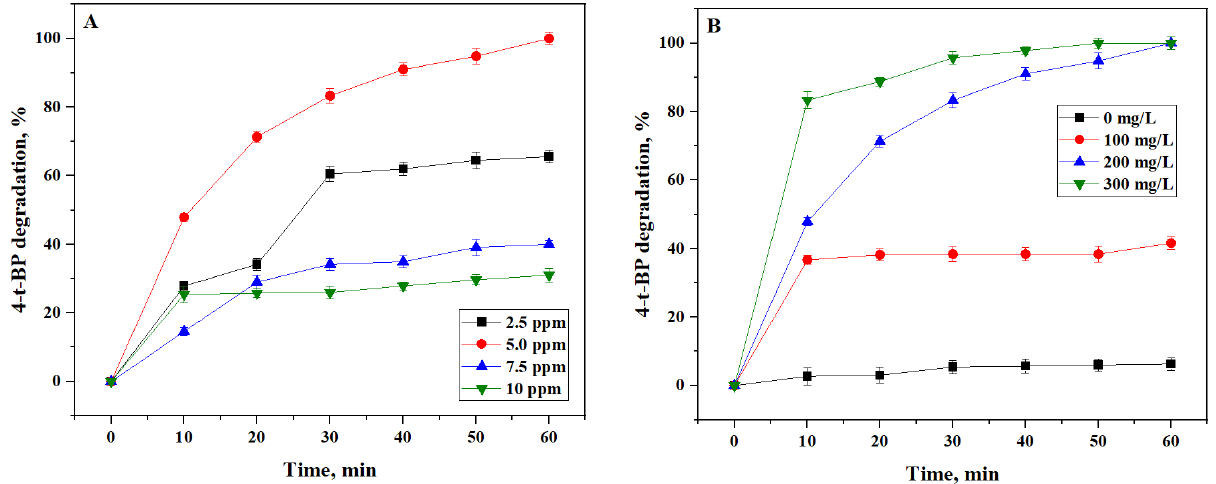
Figure 5. ( A ) Effect of initial 4-t-BP concentration (catalyst dosage = 200 mg/L) and ( B ) Effect of catalyst dosage ([4-t-BP] 0 = 5 ppm) on the degradation of 4-t-BP under solar light. To study the effect of Ag 2 CO 3 on the degradation of 4-t-BP, different Ag 2 CO 3 dosages (100, 200, and 300 mg /L) were used. As shown in Figure 5B, only 6.3% of 4-t-BP was de- graded after 60 min in the absence of catalyst, indicating that 4-t-BP could not be effec- tively degraded by solar light only. As expected, 4-t-BP degradation was enhanced when